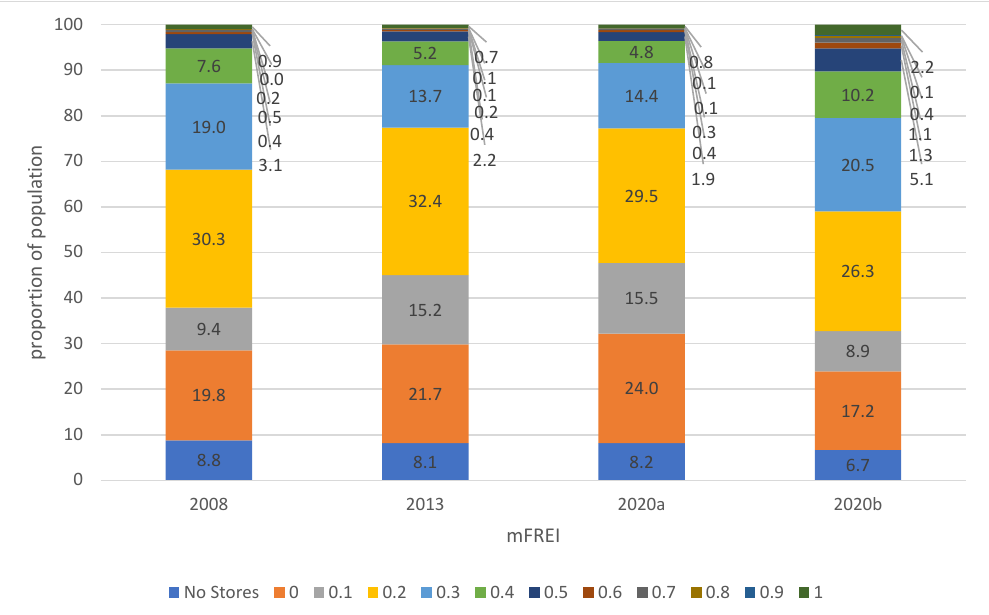
Figure 5. The evolution of food swamps in residential areas between 2008 and 2020, expressed on an area basis. The proportions are based on the total area of the residential areas. 2008, 2013 and 2020a are the food swamp scores based on Locatus data only. 2020b are the food swamp scores based on the Locatus data and the extra dataset of community gardens, farmers’ markets and farmers’ outlets.